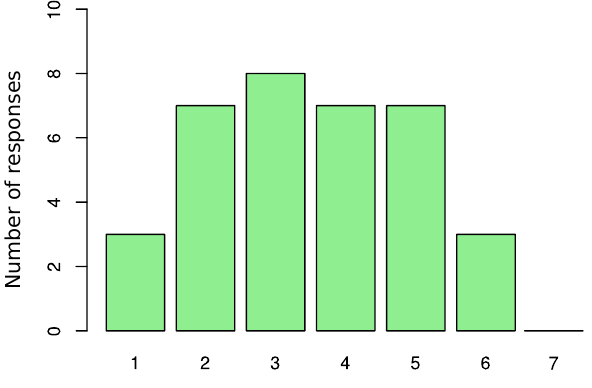
Figure 8. Distribution of answers on consent to monitor emotions at